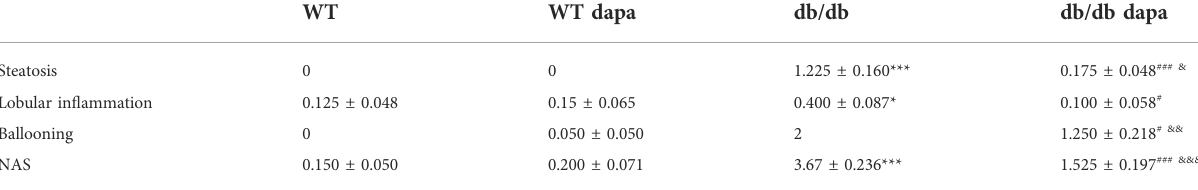
TABLE 1 NAFLD activity score (NAS).